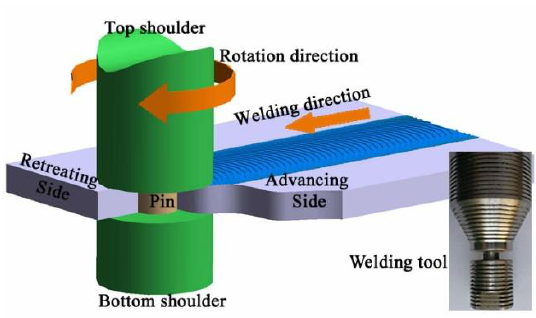
Figure 1. Schematic illustration of the bobbin tool friction stir welding (BT-FSW) process.